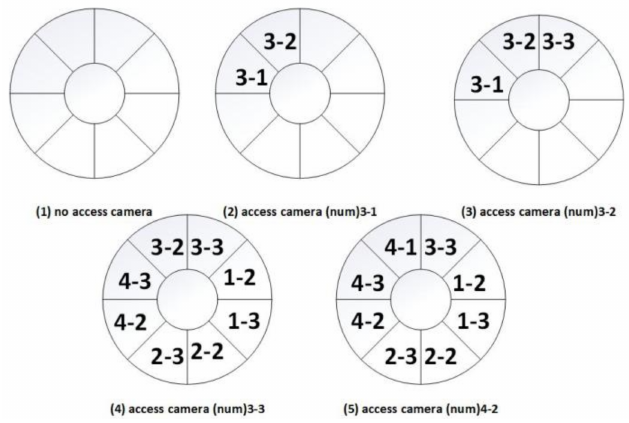
Figure 3. Cache pool